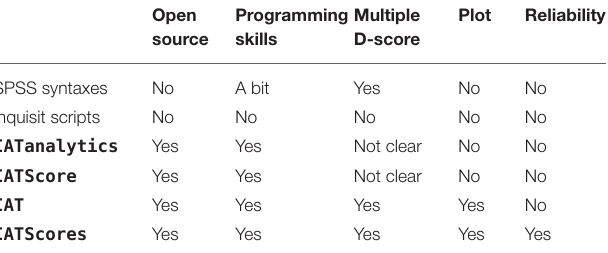
TABLE 3 | Overview of the available options for computing the D-score